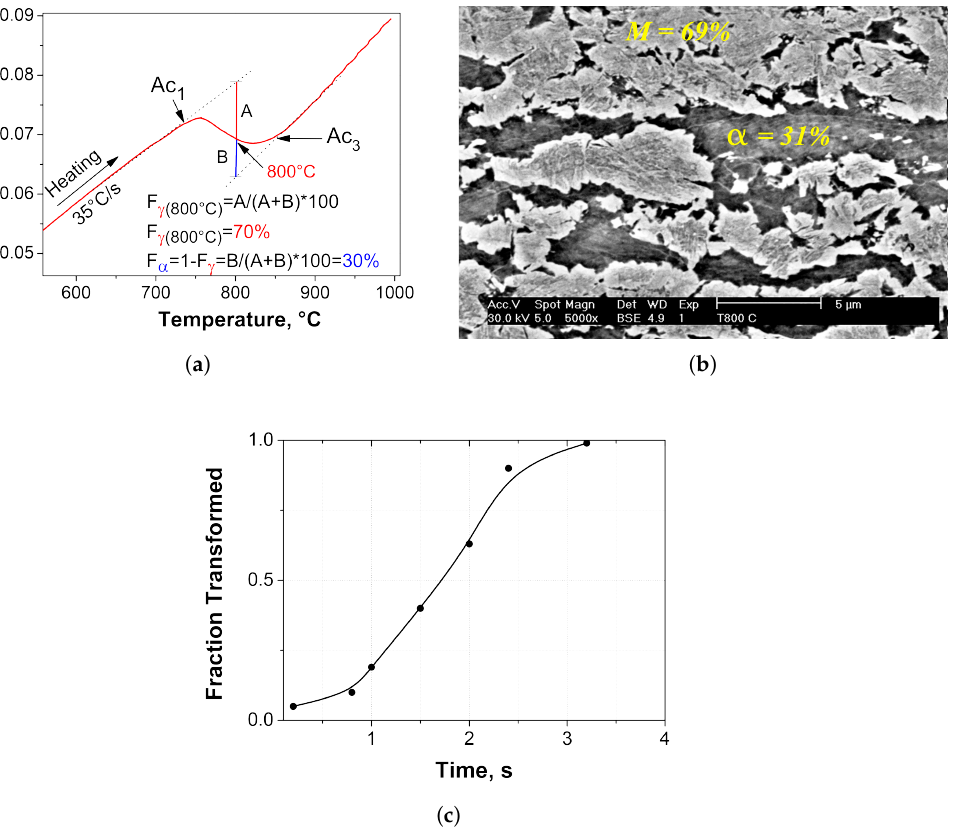
Figure 4. Determination of ferrite and austenite existing at the intercritical temperature of 800 ◦ C: ( a ) graphical method of the lever rule (30% ferrite and 70% austenite); ( b ) quantitative metallography (31% ferrite and 69% austenite) etched by 2% Nital; ( c ) austenite fraction vs. time curve showing the total transformation kinetics in continuous